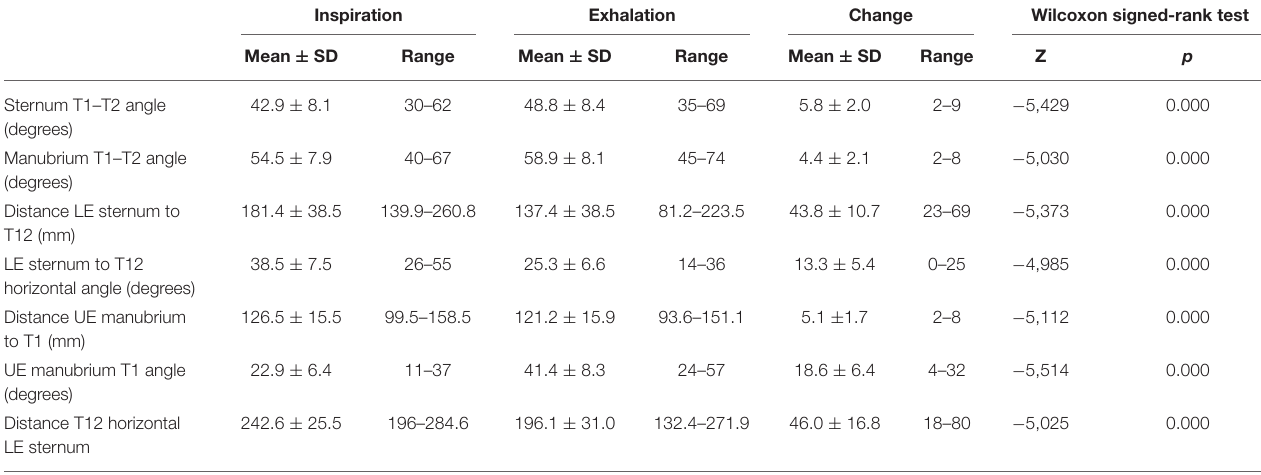
TABLE 4 | Mobility of the thoracic spine with respect to the sternum and manubrium. Inspiration Exhalation